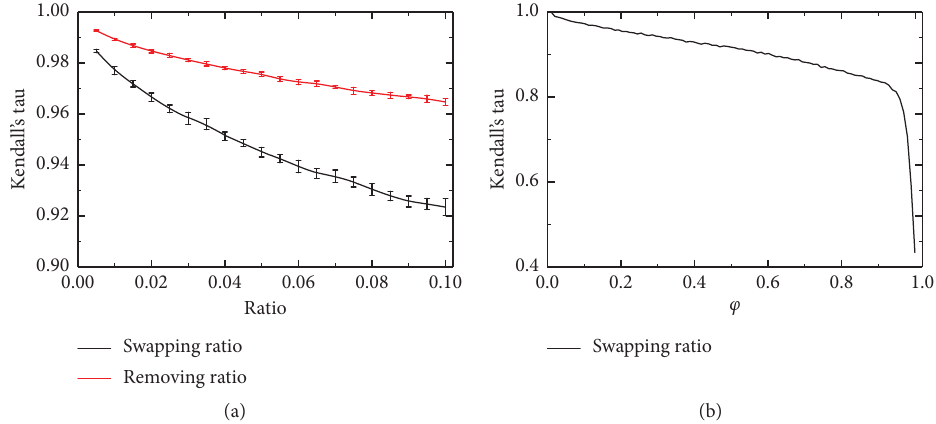
Figure 4: The effect of incomplete information and inputted matrix size. (a) The significance of nested structure under incomplete information. (b) The significance of nestedness in the varied structured